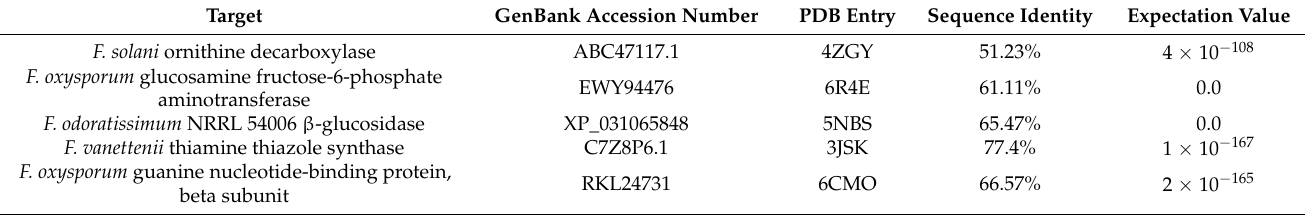
Table 1. Structure templates from PDB used for homology modeling for the Fusarium